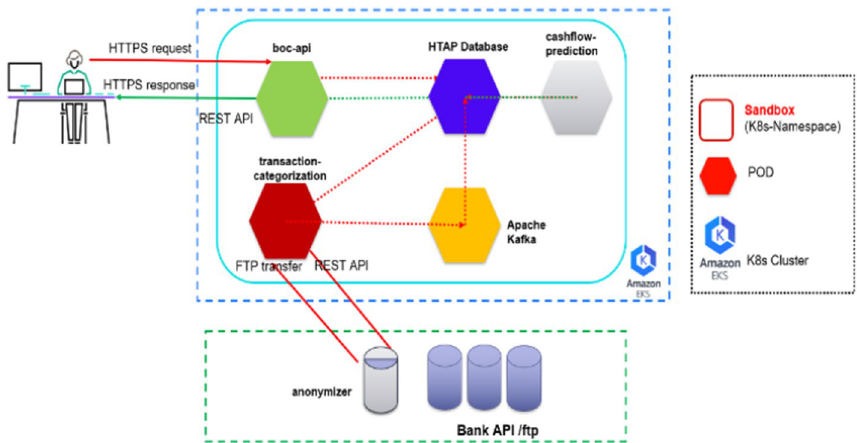
Fig. 4 Conceptual architecture of the proposed approach